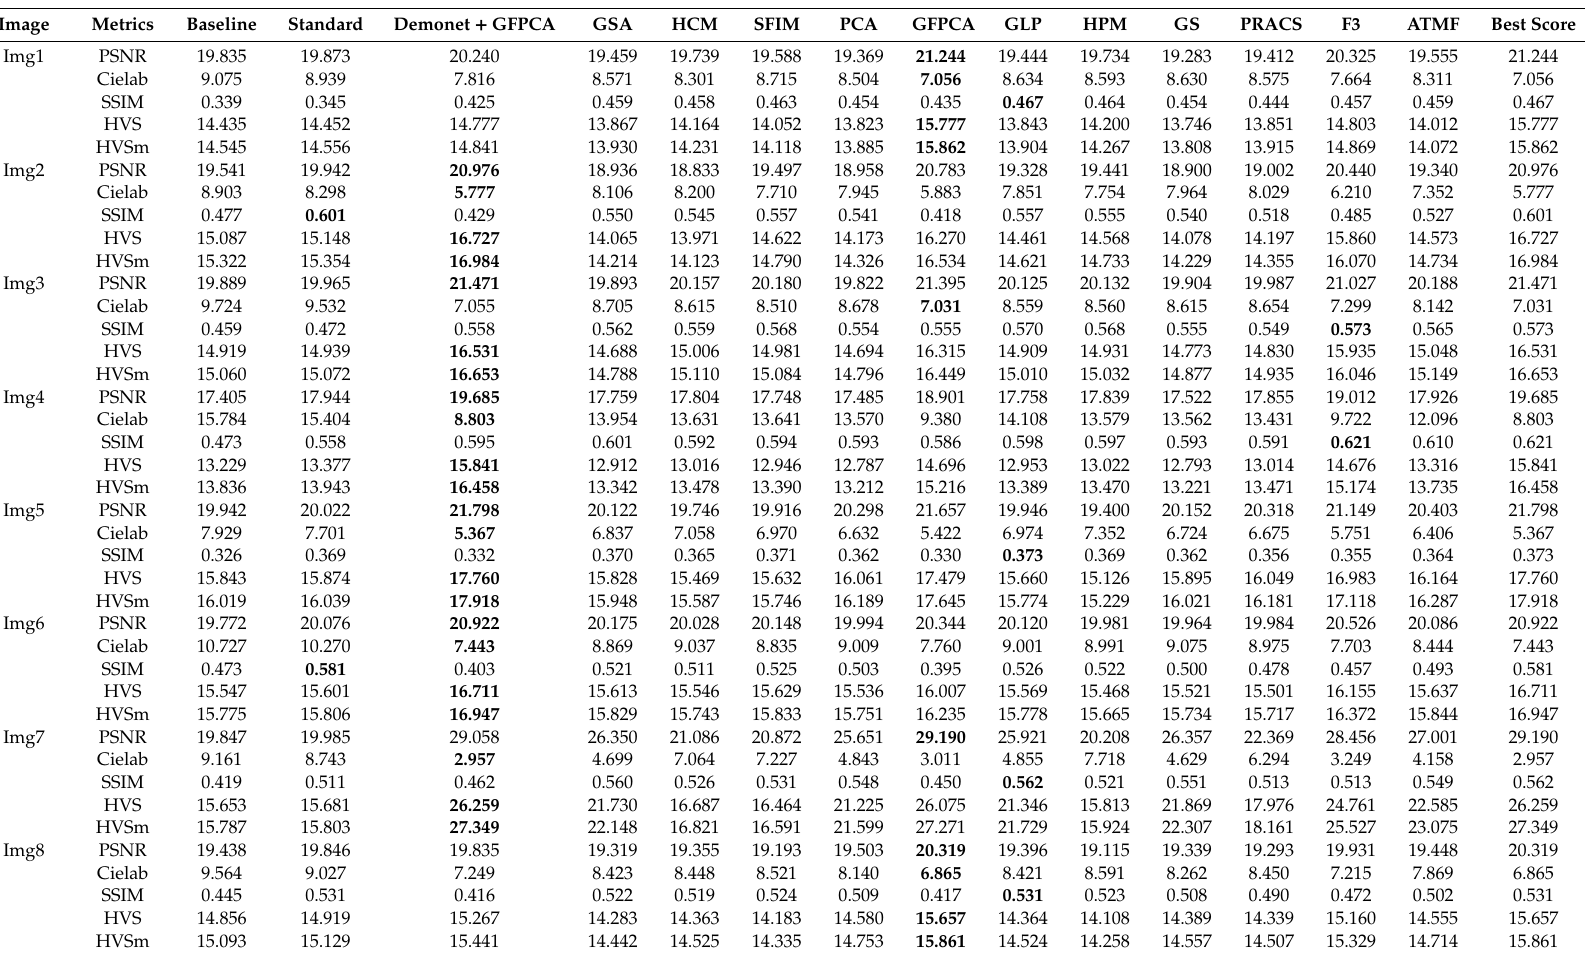
Table A7. Performance metrics of 14 algorithms at 20 dBs SNR (Poisson noise). Bold numbers indicate the best performing methods in each row. Red numbers indicate those methods used in F3 and those red and green numbers indicate those methods used in